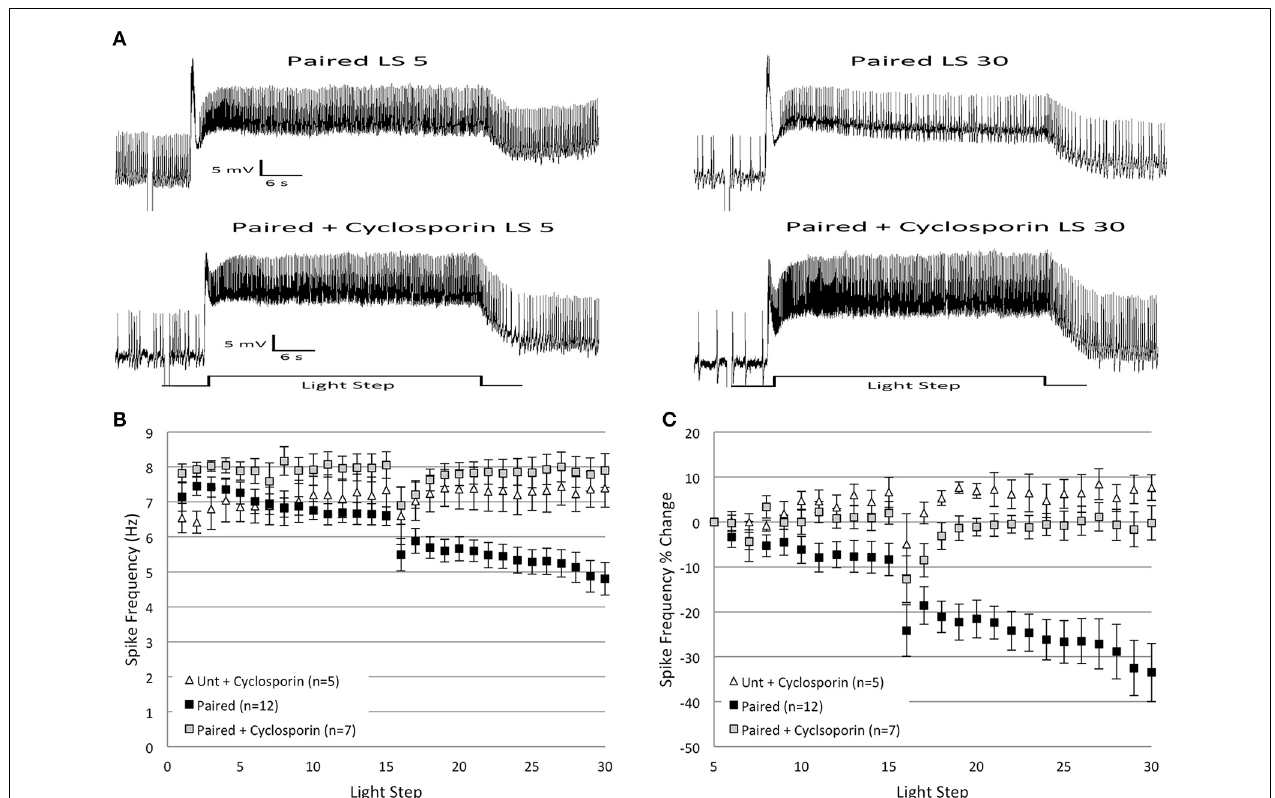
FIGURE 6 | Injection of cyclosporin A (100nM in electrode) into Paired Type B cells at the start of in vitro extinction blocked the progressive reduction in spike frequency produced by repeated LSs in Paired cells. (A) Representative light responses recorded from a Paired Type B cell (top trace) and a Paired cell incubated in cyclosporin A ( Paired + Cyclosporin ; bottom trace). The Paired cell showed a clear decrease in spike frequency from the 5th to 30th LS, while the Paired + Cyclosporin cell exhibited no change. (B) Summary spike frequency data over 30 LSs of Type B cells injected with cyclosporin. The progressive reduction in spike frequency exhibited by Paired (no drug) cells during LSs 16–30 was abolished when